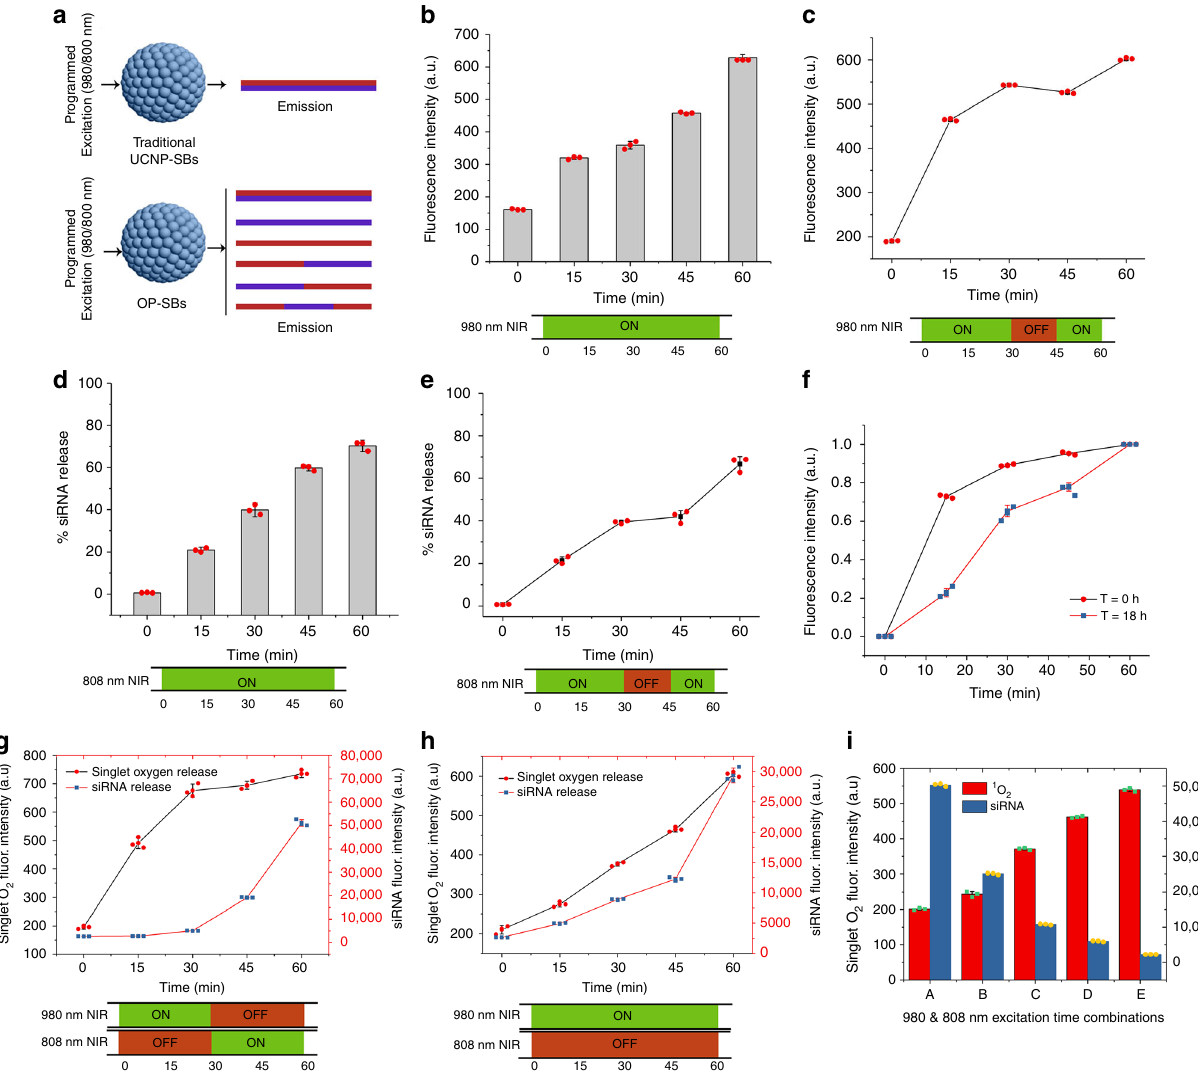
Fig. 2 Orthogonal photoactivation of multiple therapeutics. a Schematic showing the difference in emission pro fi le between Control-SBs@azo-Psi and OP- SBs@azo-Psi with programmed activation using 980/808 nm laser. b Release of singlet oxygen from OP-SBs@azo-Psi in solution over time with 980 nm irradiation. c Step-wise release of singlet oxygen from OP-SBs@azo-Psi in solution with 980 nm irradiation. d Release of siRNA from OP-SBs@azo-Psi in solution over time with 808 nm irradiation. e Step-wise release of siRNA from OP-SBs@azo-Psi in solution with 808 nm irradiation. f Singlet oxygen production using 980 nm excitation of the same OP-SBs@azo-Psi at different time points. g Orthogonal activation of singlet oxygen production and siRNA release from OP-SBs@azo-Psi over time. h Non-orthogonal activation of singlet oxygen production and siRNA release from Control-SBs@azo-Psi over time. i Programmed activation of OP-SBs@azo-Psi with different durations of 980 and 808 nm NIR irradiation. Error bars represent the standard deviation of measurements from three ( n = 3) distinct